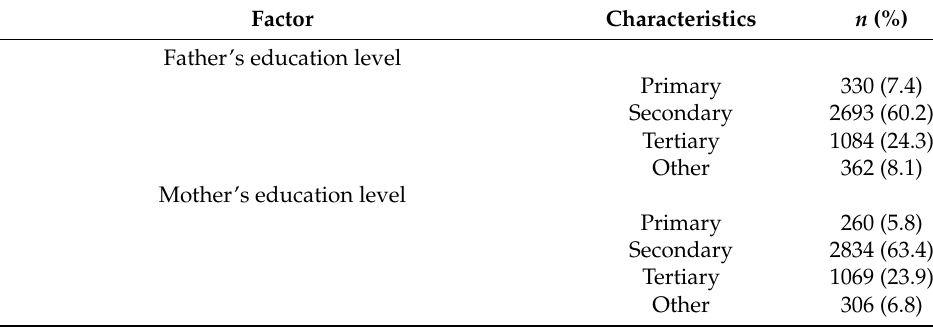
Table 3. Distribution of Family Factors ( n =